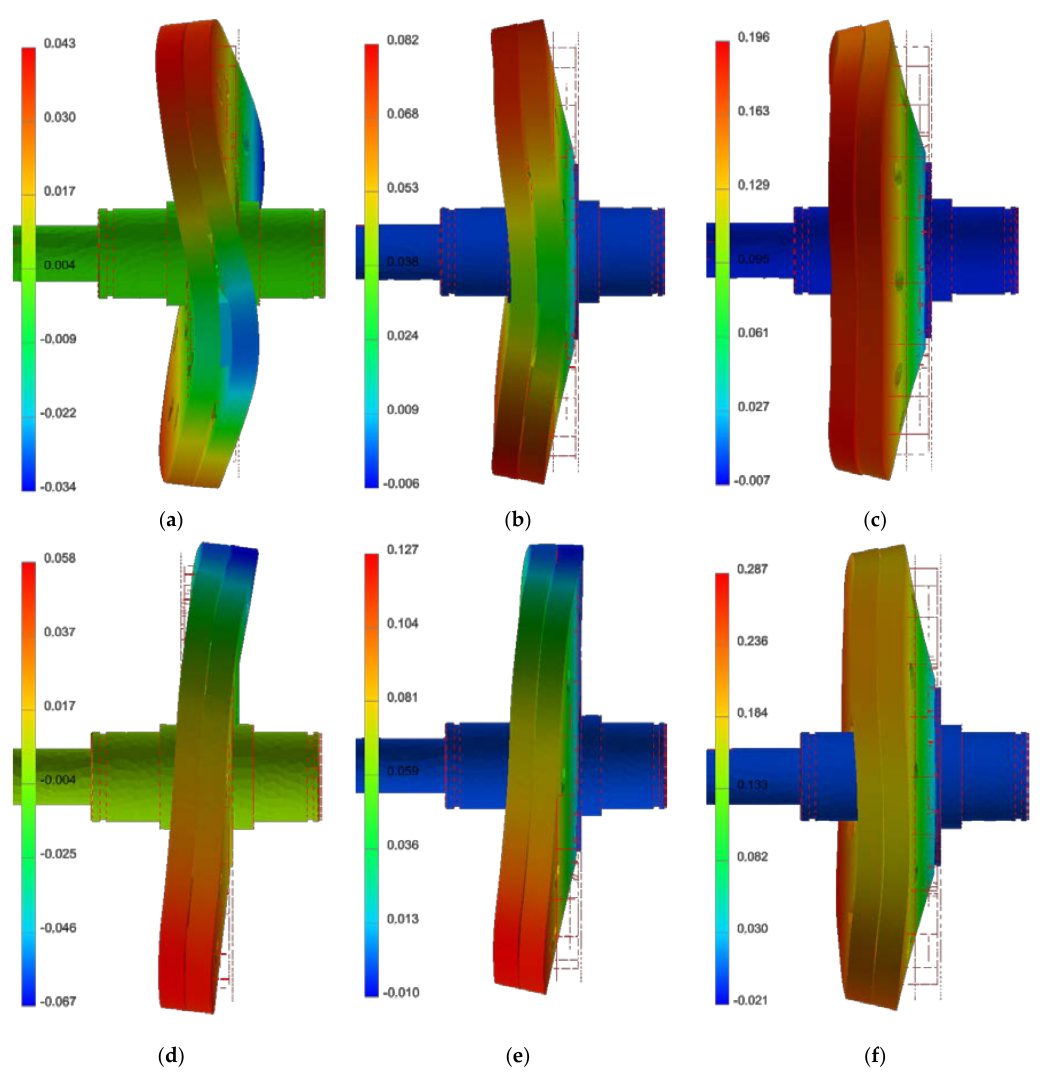
Figure 14. Results of displacements in the Z axis at a max load for Ag asm = − 0.5, Ag asm = 0, and Ag asm = +1